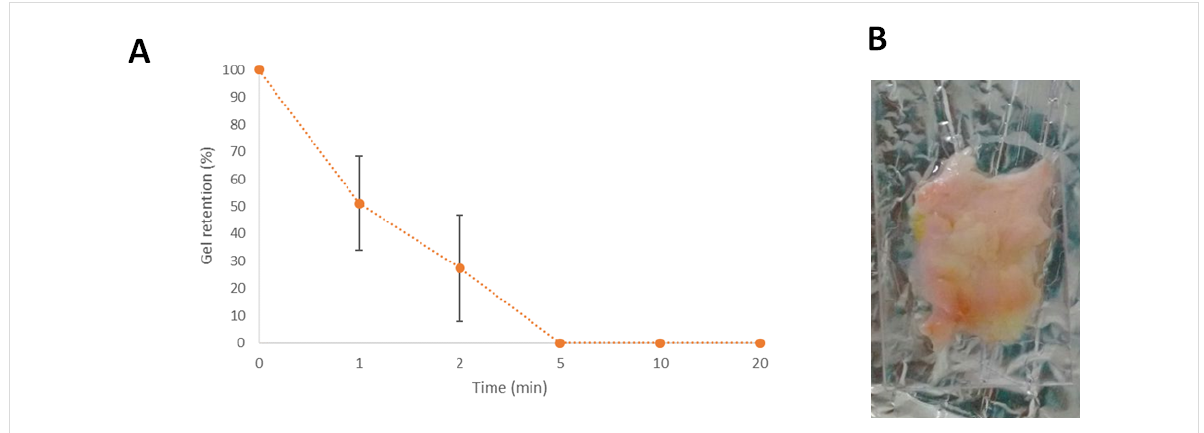
Figure 9: (A) Cumulative retention profile of a polymeric system containing poloxamer 407, Carbopol 974P ® and curcumin retained in a mucous layer versus time. (B) Oral porcine mucosa after the end of the